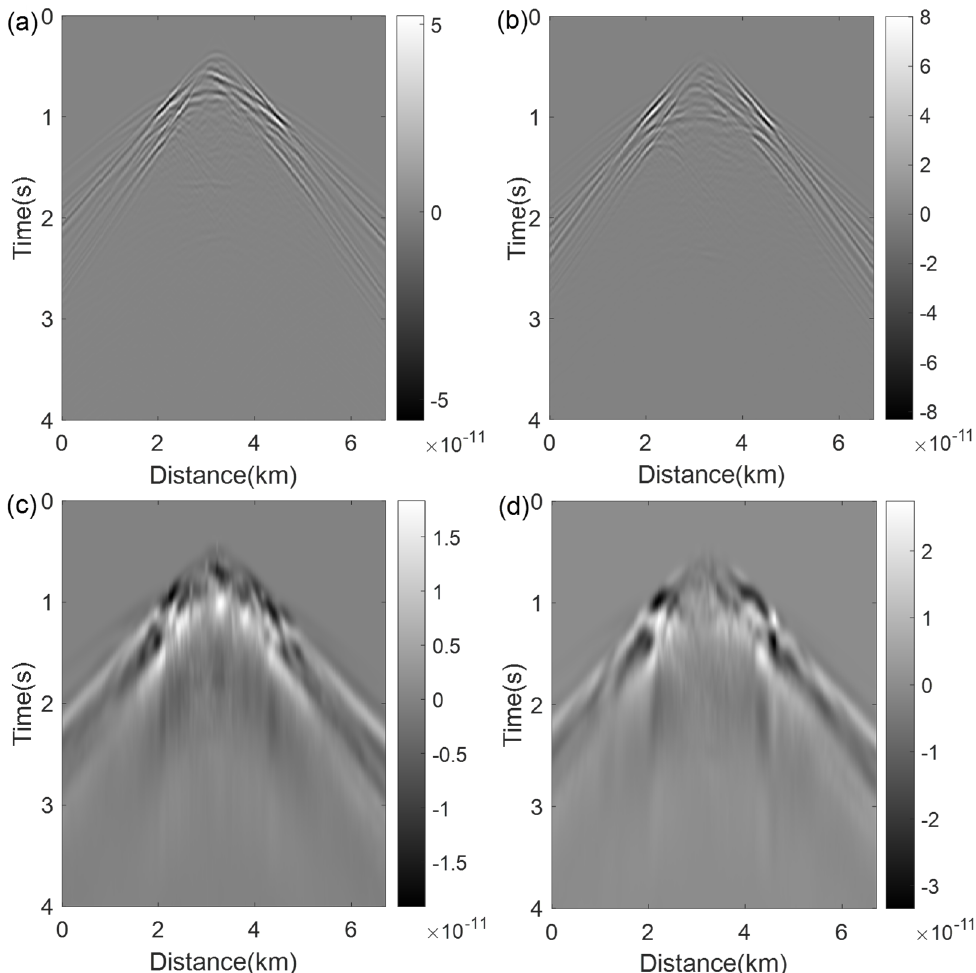
Figure 8. Adjoint sources comparison. ( a ) Z-component of the adjoint source of EFWI; ( b ) X-component of the adjoint source of EFWI; ( c ) Z-component of the adjoint source of EDEI; ( d ) X-component of the adjoint source of EDEI.